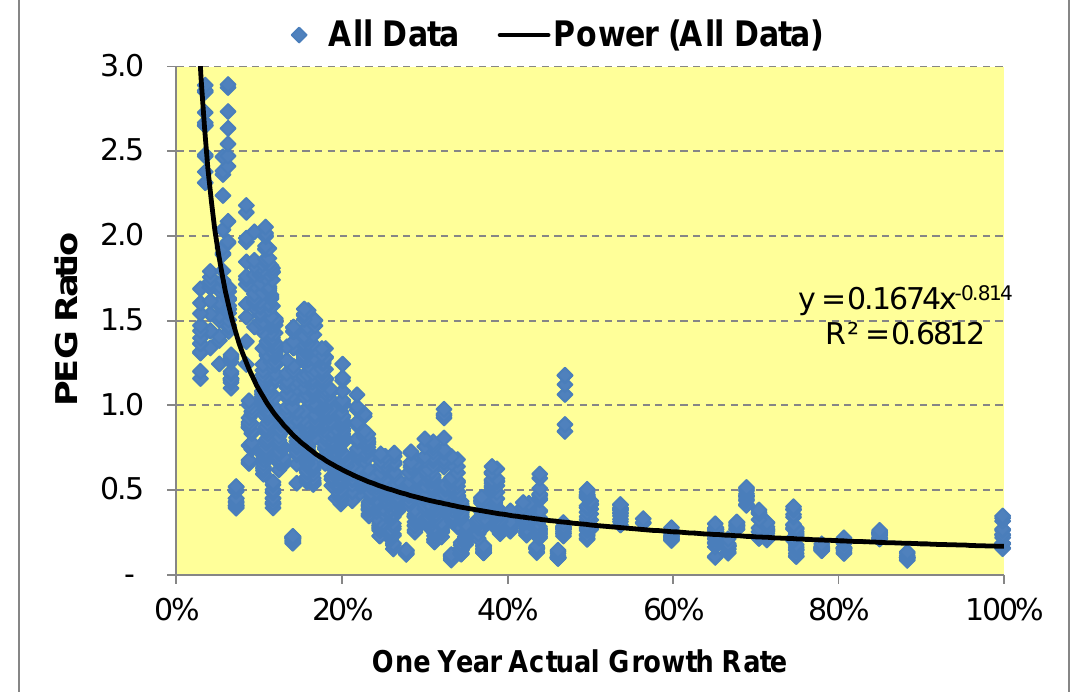
Figure 1: Confirming Trombley's (2008) observation of PEG vs. G% Table3: PEG trading rule criteria for PEG (Trombley, T